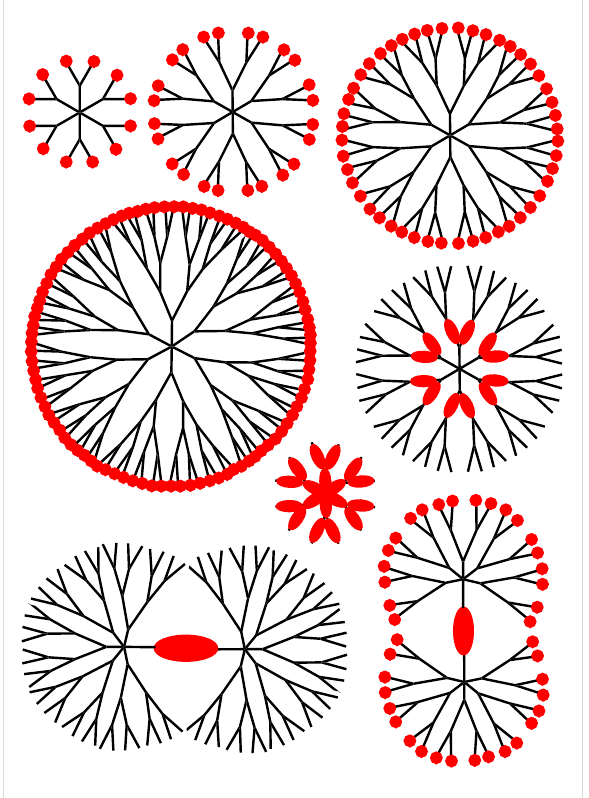
dendrimer was not induced by TPA but classically by one photon.